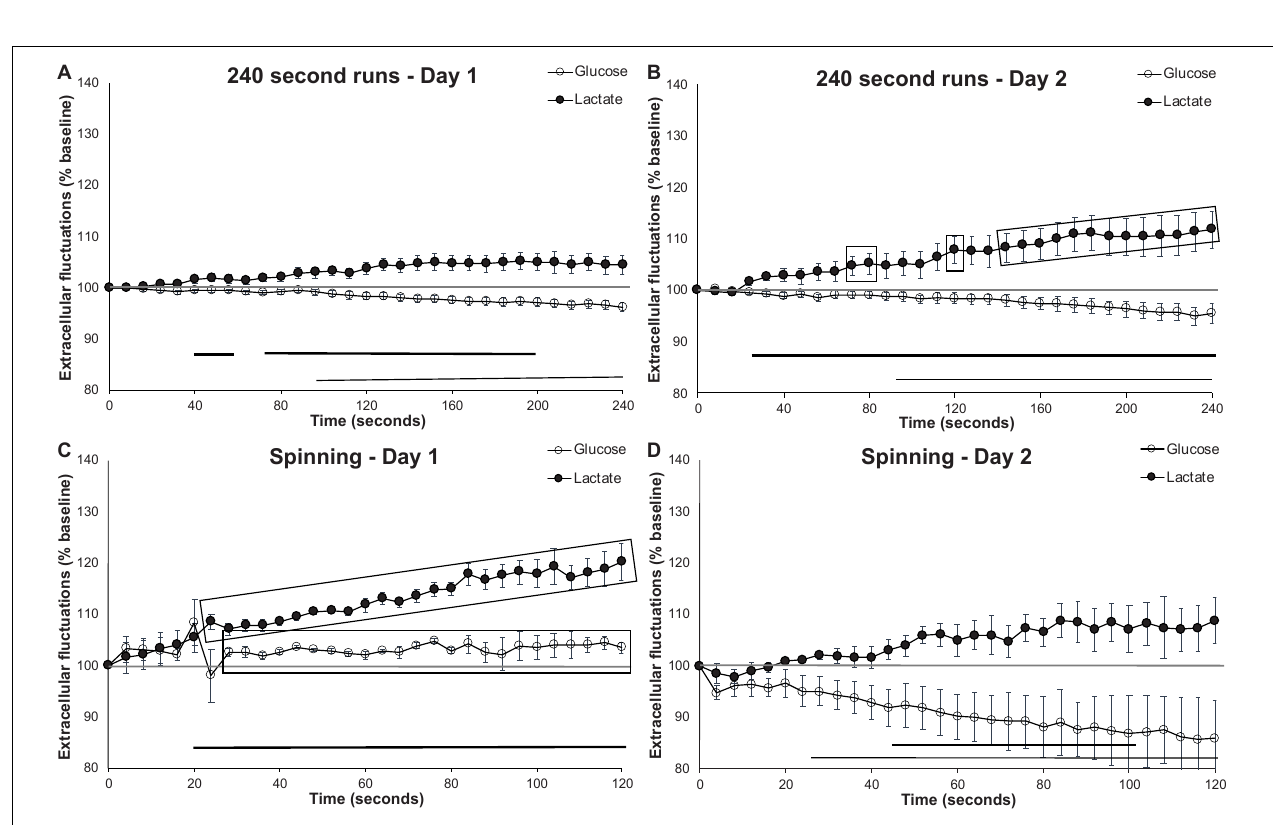
FIGURE 4 | Effect of novelty on extracellular glucose and lactate. Comparing extracellular cortical glucose (open circle) or lactate (filled circle) on day 1 and day 2 of testing. (A) Running events of at least 240 s on the first day of running wheel access ( n events = 23, n mice = 10). (B) Running events of at least 240 s on the second day of running wheel access ( n events = 12, n mice = 10). (C) Spinning events on the first day of testing ( n = 3) and (D) spinning events on the second day ( n = 4). Gray-shaded rectangles surrounding the glucose and lactate curves indicate significant differences from day 1 and day 2 of testing, for both extracellular glucose (open circle) and lactate (filled circle). Horizontal lines below the data indicates significant ( p < 0.05) differences from baseline for both extracellular glucose (thin line) and lactate (thick line). The mid-graph gray line shows baseline (100%) value.